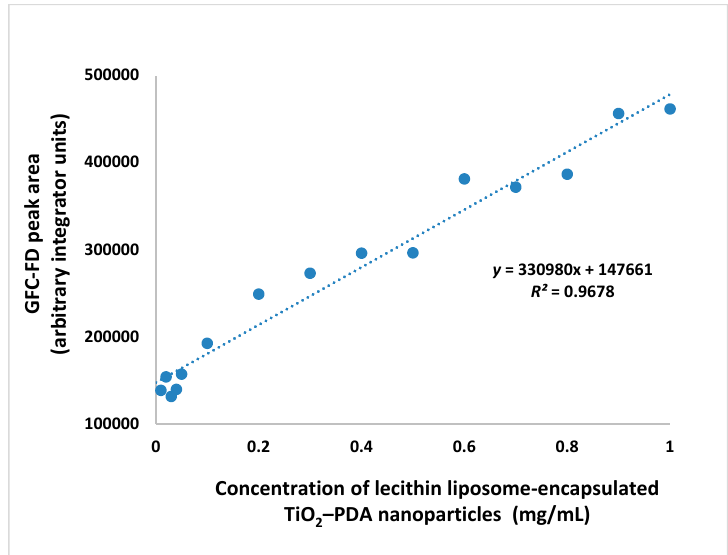
Figure 3. Standard calibration curve for rapid GFC analysis of lecithin liposome-encapsulated TiO 2 -PDA nanoparticles, using λ ex = 365 nm and λ em = 460 nm for FD.